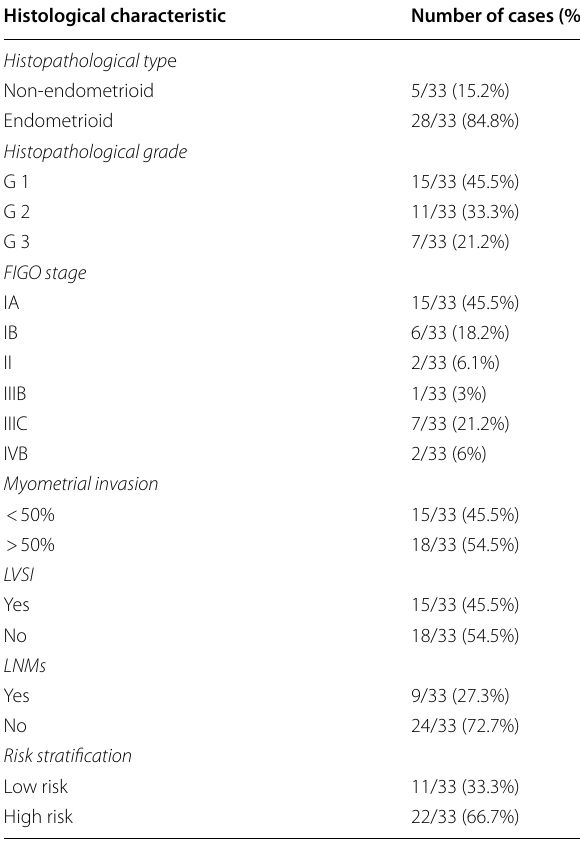
LVSI, Lymphovascular space invasion, LNMs, Lymph nodes metastases